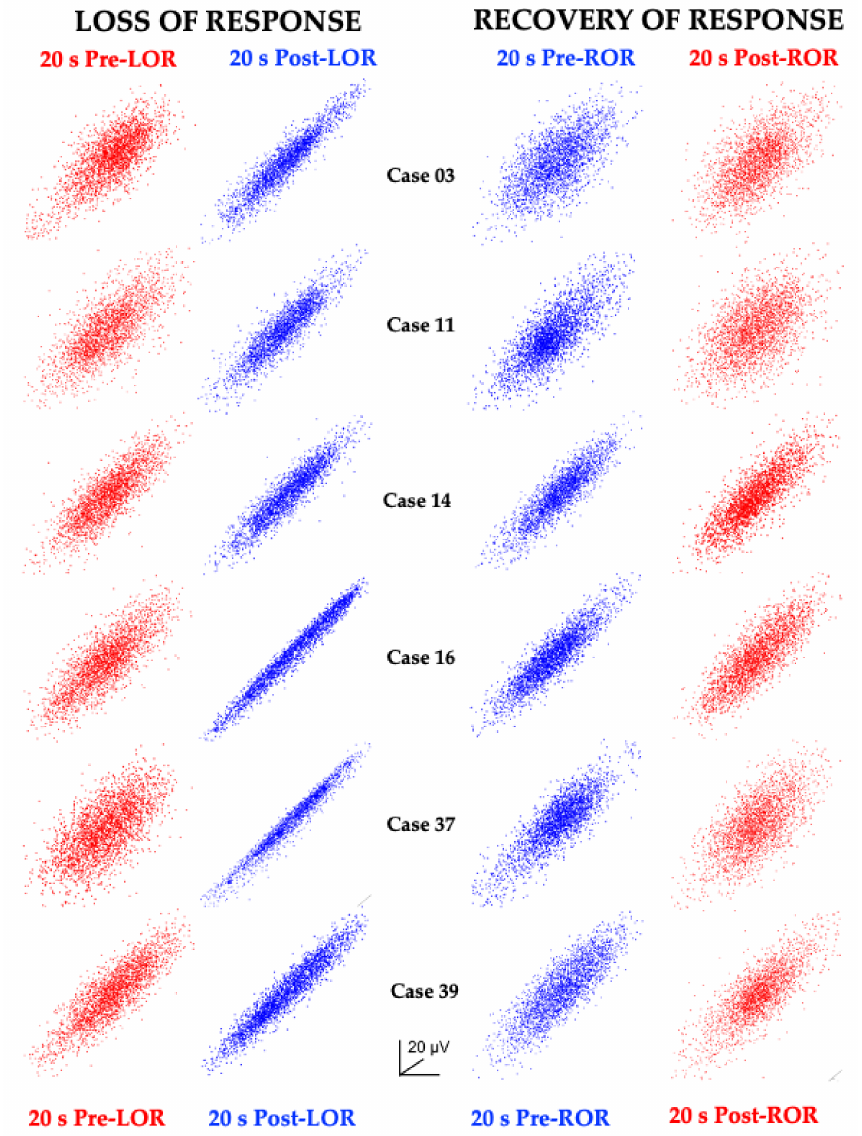
Figure 10. Attractor shapes consistently change across patients anesthetized with remifentanil and nitrous oxide. Attractors generated from 20 s EEG clips before and after loss of response (LOR) and recovery of response (ROR) from six patients show flattening and more ellipsoidal shapes following LOR, and more spherical shapes following ROR consistently across patients anesthetized with remifentanil and nitrous oxide. Awake, responsive states are shown in red, and anesthetized, unresponsive states are shown in blue. Reproduced with permission from Reference